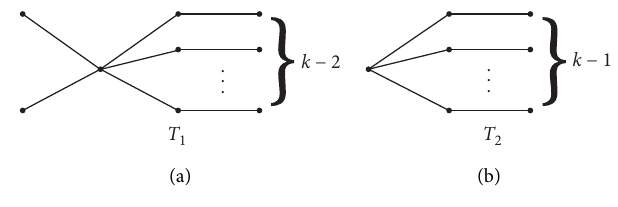
Figure 2: The graph T